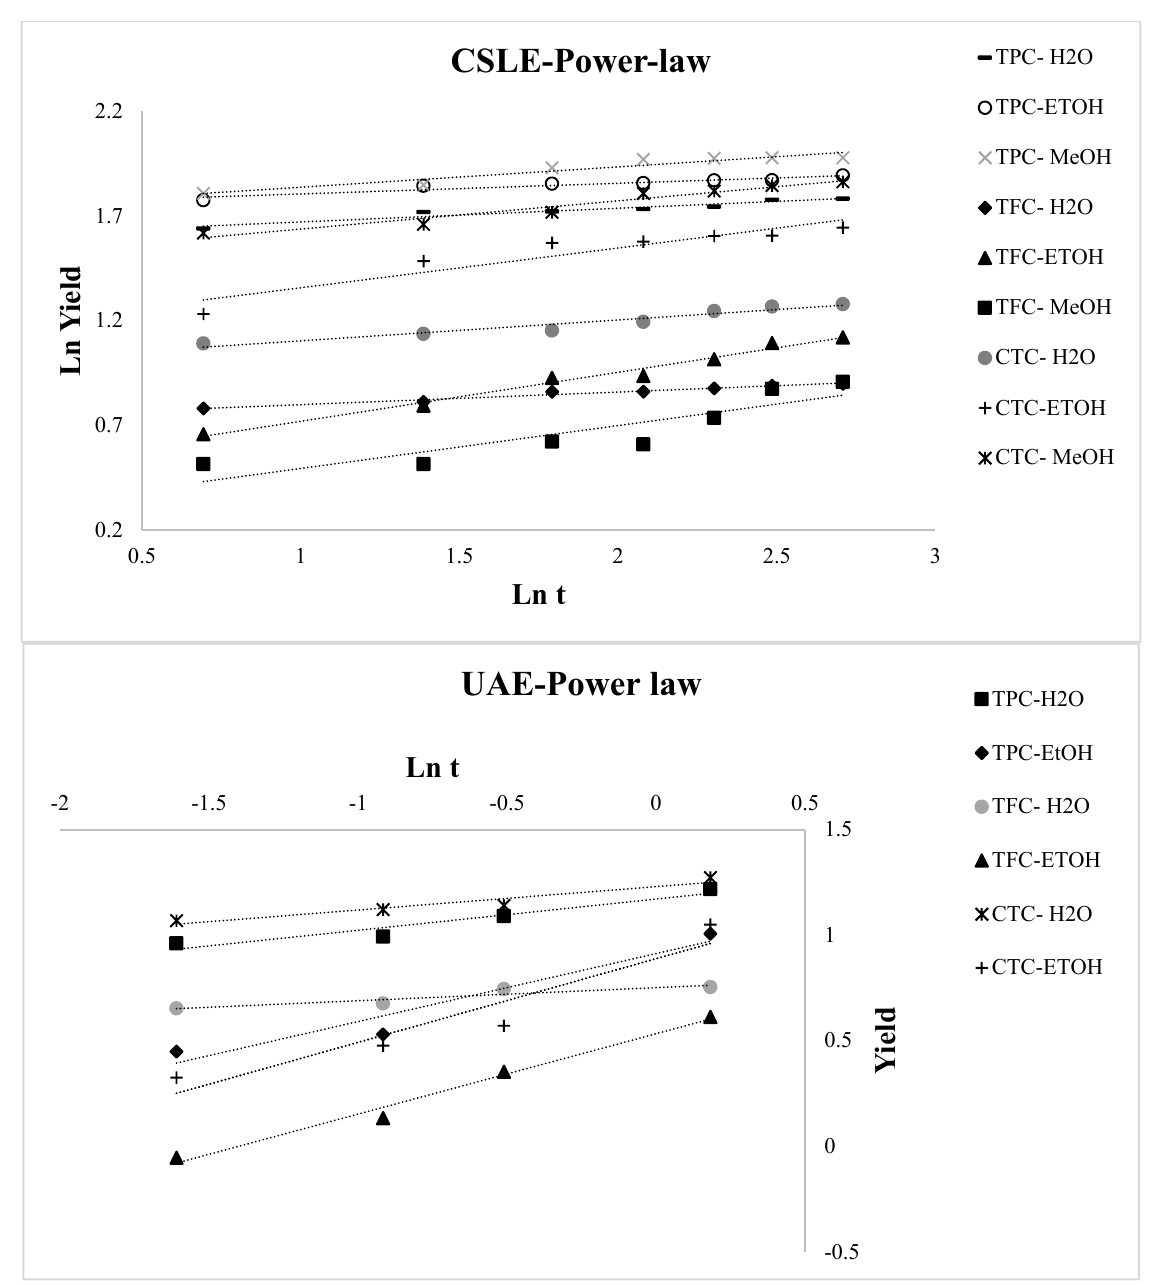
Figure 5. Plot of power-law model for conventional solid-liquid extraction (CSLE) and ultrasound-assisted extraction (UAE) for the total phenolic compound (TPC), total flavonoid compound (TFC), and total condensed tannin compound (CTC) using the different selected solvents.